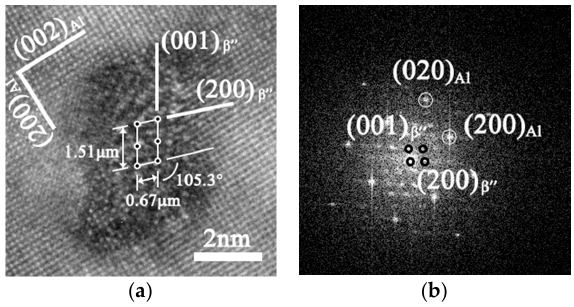
Figure 4. High-resolution TEM (HRTEM) images of a representative β′′ precipitate imaged parallel to the <010> Al axis of the precipitates in the peak-aged (170 °C/5 h) Al-Mg-Si alloy: ( a ) HRTEM image and ( b ) the corresponding fast Fourier filtering transform (FFT) pattern.